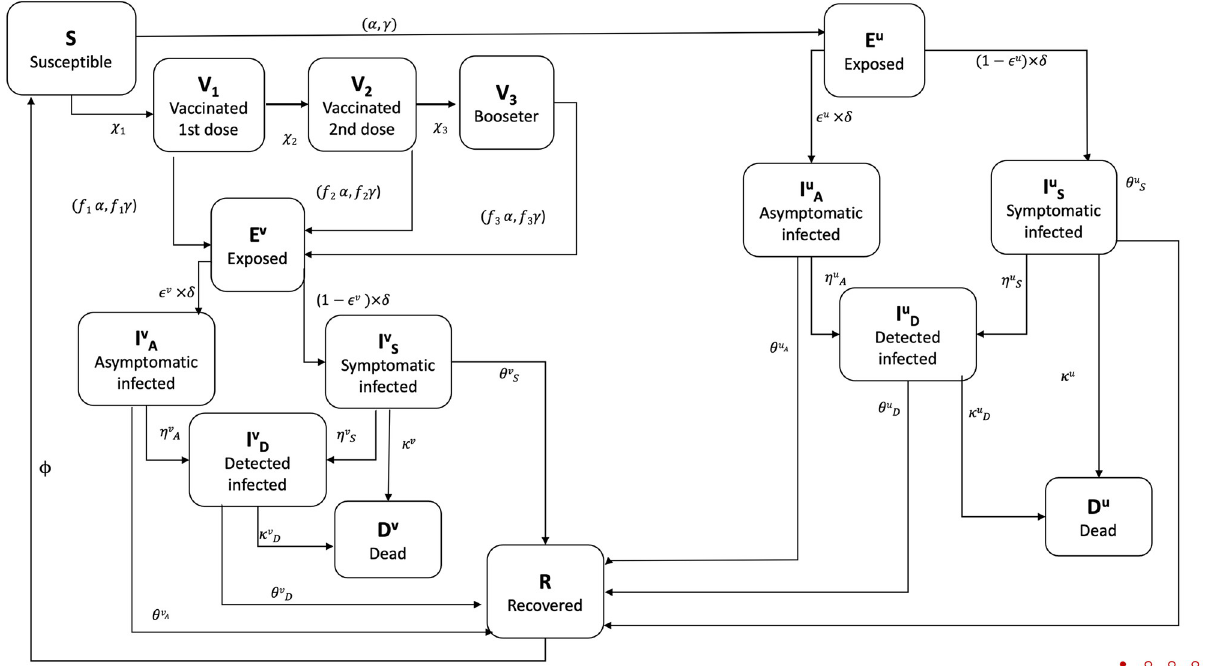
Fig 1. Flow chart summarizing the state variables, fluxes among compartments and related model parameters.